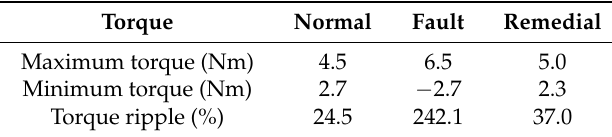
Table 2. Torque performance under various conditions.